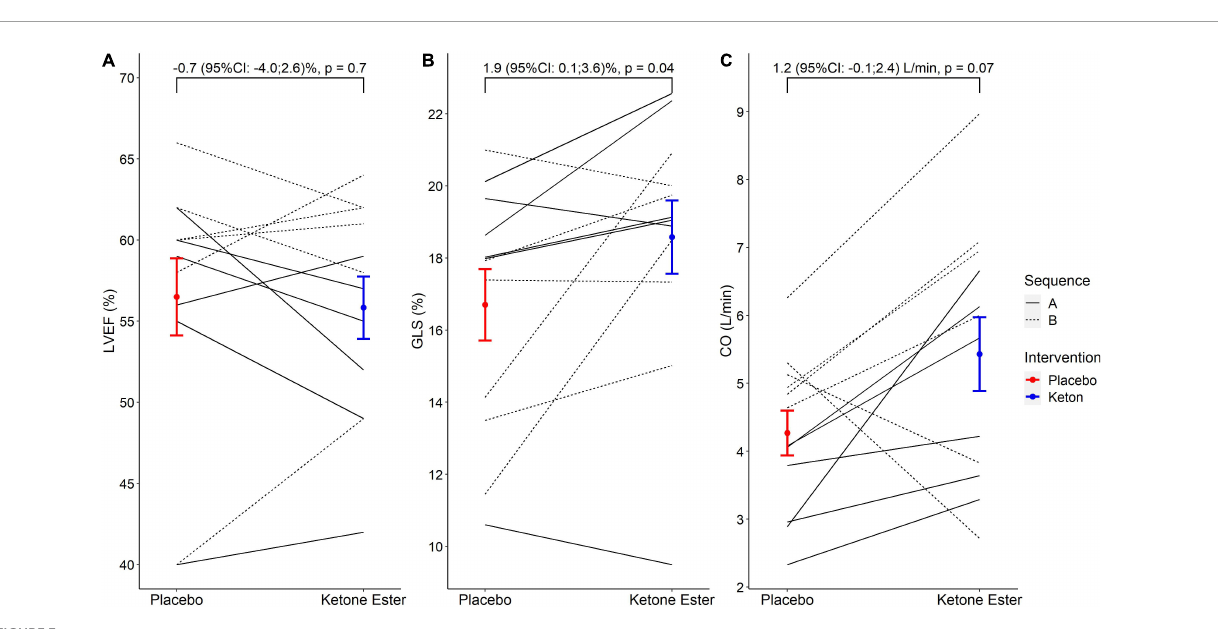
FIGURE3 The effects of oral ketone esters on LVEF, GLS, and cardiac output. The figure depicts the absolute changes (mean ± SEM) between placebo and oral ketone esters for LVEF (A) , GLS (B) , and cardiac output (C) , respectively. The brackets report unadjusted mean differences (95% CI) with p -values. LVEF, left ventricular ejection fraction; GLS, absolute global longitudinal